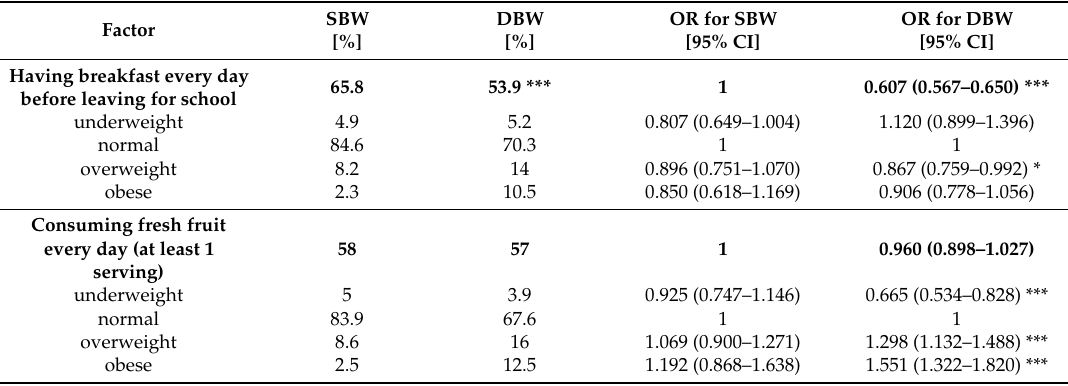
Table 2. Nutritional behaviors of the individuals ( n = 14,044) depending on satisfaction (SBW) or dissatisfaction (DBW) with body weight and the logistic regression analyses for the association of SBW or DBW with nutritional